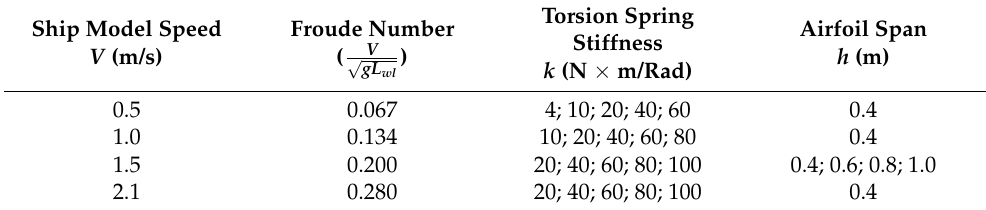
Table 4. The parameters for the simulation.